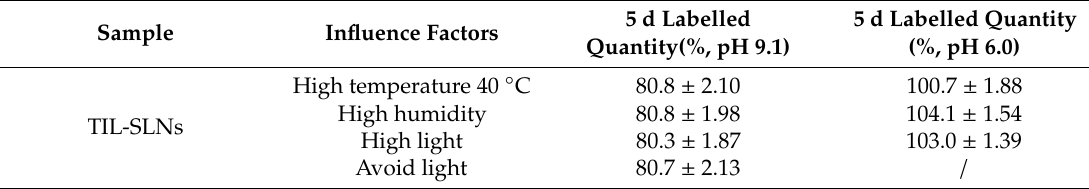
Table 2. The influence factors test of TIL-SLNs (Mean ± SD, n =